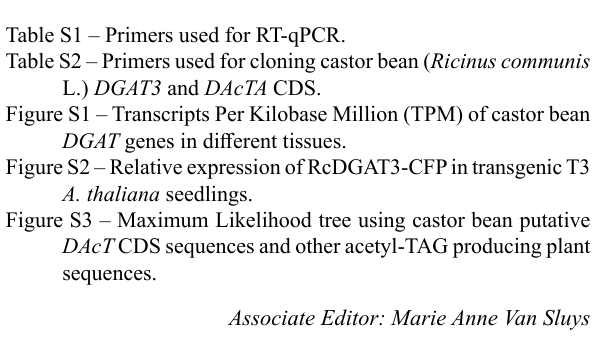
Figure S1 – Transcripts Per Kilobase Million (TPM) of castor bean DGAT genes in different tissues. Figure S2 – Relative expression of RcDGAT3-CFP in transgenic T3 A. thaliana seedlings. Figure S3 – Maximum Likelihood tree using castor bean putative DAcT CDS sequences and other acetyl-TAG producing plant